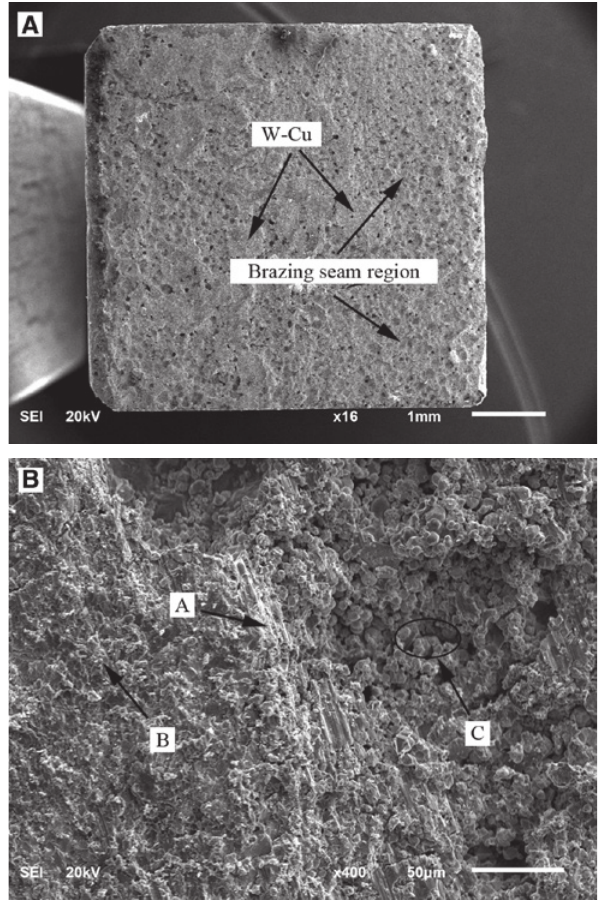
Figure 9: Fracture morphology of NiMnSiCuZr brazed joint: (A) macroimage; (B)